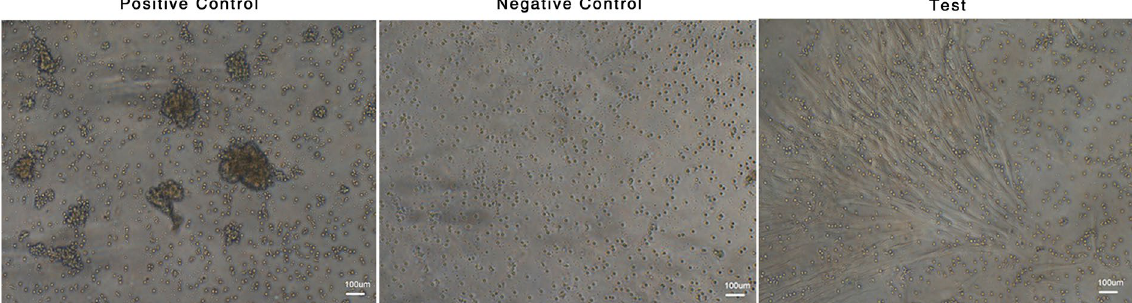
Figure 6. Immune suppression assay by mixed lymphocyte reaction. Representative bright-field images of positive control (PBMNC with PHA) showing aggregation of cells indicating proliferation of lymphocytes, negative control (PBMNC without PHA) showing no aggregation stating for the absence of proliferation of lymphocytes and PL expanded MSCs co-cultured with allogeneic PBMNC in the presence of PHA showing considerably less aggregates indicative of